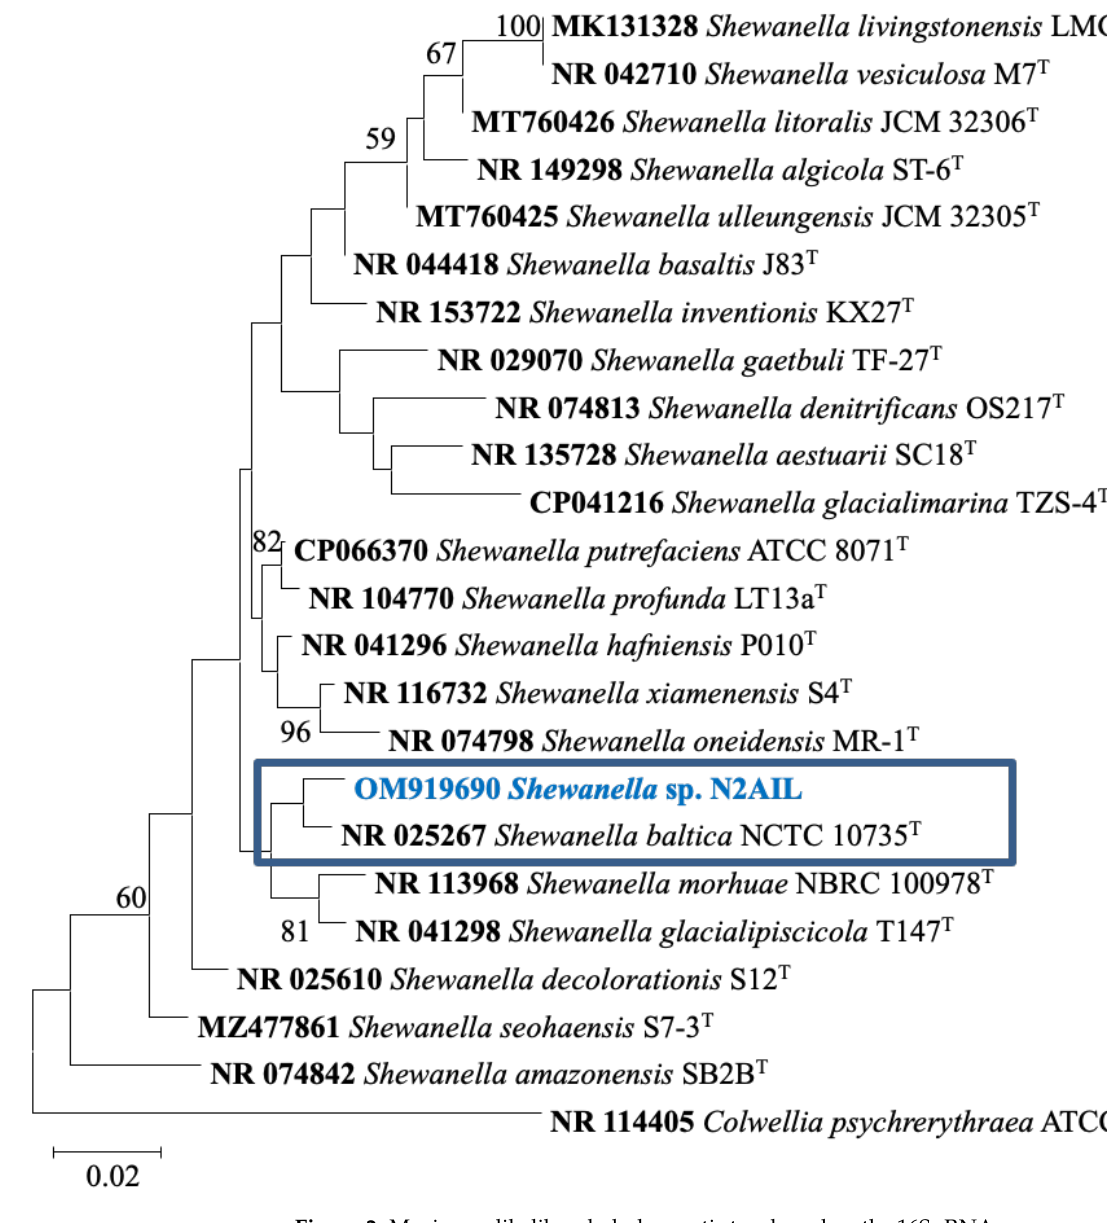
Figure 2. Maximum likelihood phylogenetic tree based on the 16S rRNA gene sequences of Shewanella sp. N2AIL along with related type strains. The values on the tree indicate the bootstrap percentages obtained after 1000 replications. The type species Colwellia psychrerythraea ATCC 27364 T was used as an outgroup. Scale bar represent 2% genetic variation.